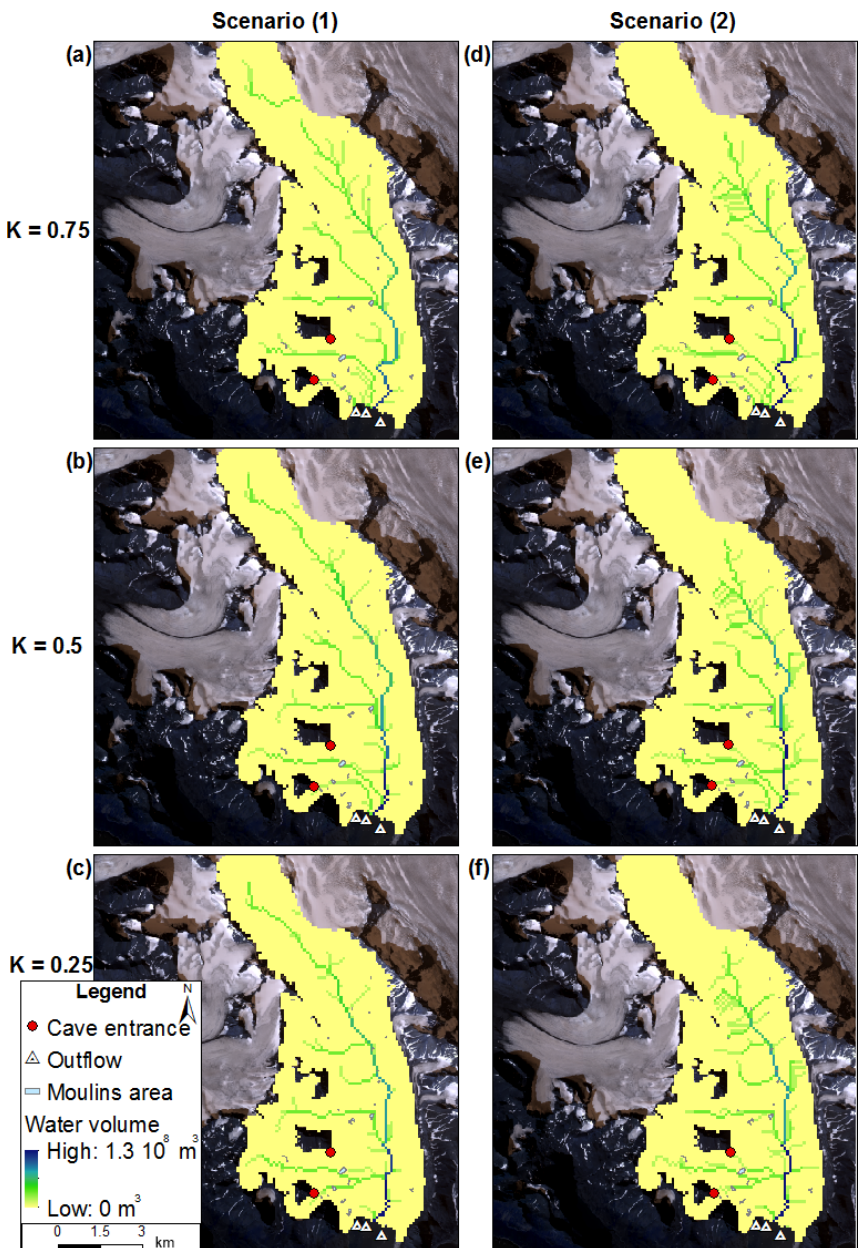
Figure A1. Map of the theoretical pattern of subglacial channels of Hansbreen modeled with scenarios (1) – K = 0 . 75 (a) , K = 0 . 5 (b) , K = 0 . 25 (c) – and (2) – K = 0 . 75 (d) , K = 0 . 5 (e) , K = 0 . 25 (f) . The map background is a WorldView-2 VHRS image acquired